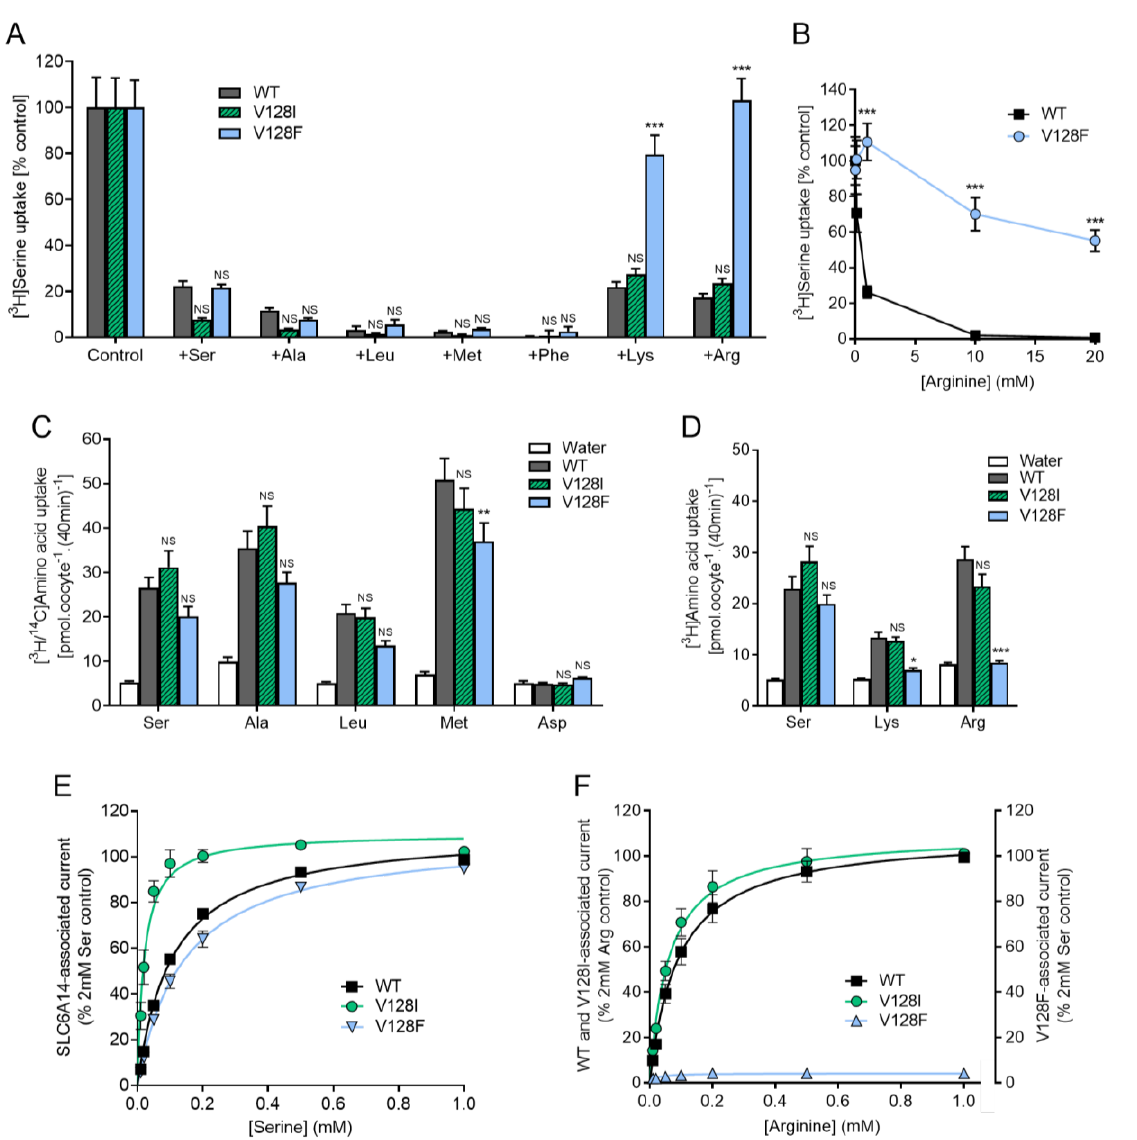
Figure 3. Substitution of V128 in TM3 selectively reduces transport of the dibasic amino acids lysine and arginine via SLC6A14. ( A , B ) Serine (10 µM) uptake into oocytes expressing SLC6A14 wild-type (WT) transporter, or SLC6A14 with the mutations V128I or V128F. Uptake was measured in the absence (control) and presence of unlabelled amino acids [( A ) 2 mM; ( B ) 0 – 20 mM]. Transporter- specific uptake is shown (after the subtraction of background uptake measured in water-injected oocytes under identical conditions). n = 18 – 20. ***, p < 0.001; NS, p > 0.05 vs. WT. ( C , D ) Uptake of various radiolabelled amino acids (all 10 µM). Oocytes injected with water, rather than cRNA, were used as a control to determine background endogenous amino acid uptake. n = 19 – 20. ***, p < 0.001; **, p < 0.01; *, p < 0.05; NS, p > 0.05 vs. WT. ( E , F ) SLC6A14-associated inward current measured by TEVC. Current was measured 60 s after sequential addition of increasing concentrations (0.01 – 1 mM) of serine ( E ) or arginine ( F ). Current measured prior to amino acid addition (i.e., in the superfusion solution but absence of amino acid) was subtracted to give amino acid-associated current. Mean current in water-injected oocytes was subtracted to give SLC6A14-specific current. Data were plotted as % of current induced by 2 mM serine or arginine. n = 6, ( E ); n = 3, ( F ). See Supplemental Figure S3 for example traces. Curves are fitted to Michaelis-Menten kinetics [r 2 = 0.989, WT; 0.839 V128I; 0.976 V128F in ( E ). r 2 = 0.968 WT; 0.959 V128I; N.D. V128F in ( F )]. As well as accepting 18 of the 20 proteinogenic amino acids, SLC6A14 can transport several drugs and prodrugs [6,16,17] including arginine, lysine and citrulline analogues that act as NOS inhibitors such as N G -monomethyl- L -arginine (NMMA, tilarginine) [15].